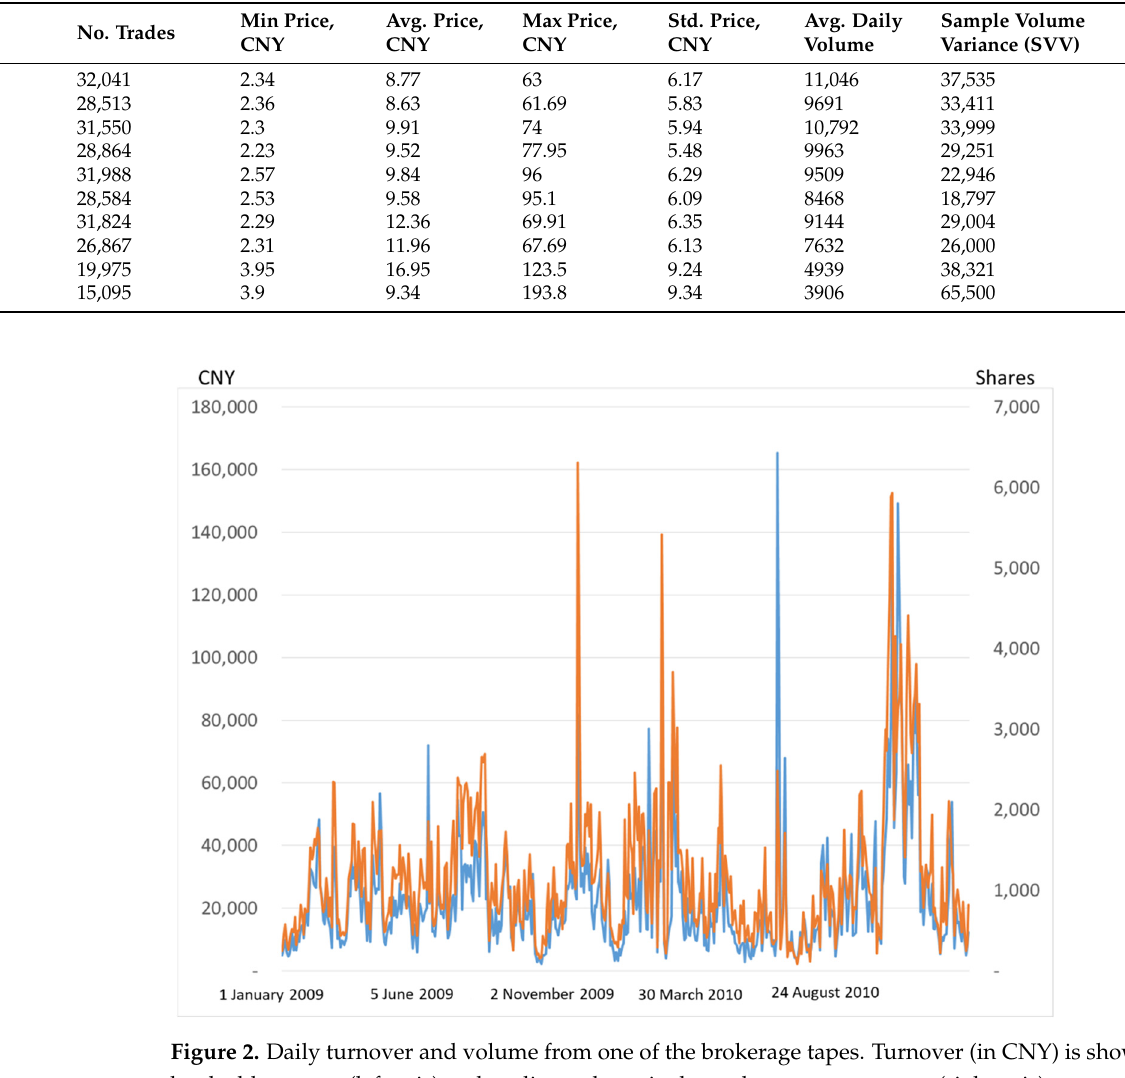
Table 1. Summary statistics of Brokerage 5 for all the 484 trading days during 2009–2010. (Table 1 queries the data from original datasets. Traders are marked as 0 through 4. Volume data are rounded to one share. The stock price is expressed in the Chinese Yuan. The index B or S refers to a “Buy” or a “Sell” order on a given tape. We used sample volume variance as an indicator of volume dispersion. The daily standard deviation of the volume can be approximated as √ 484 times √ SVV. There is no systematic difference between the first four tapes, while records in the fifth tape gravitate towards higher-priced stocks.